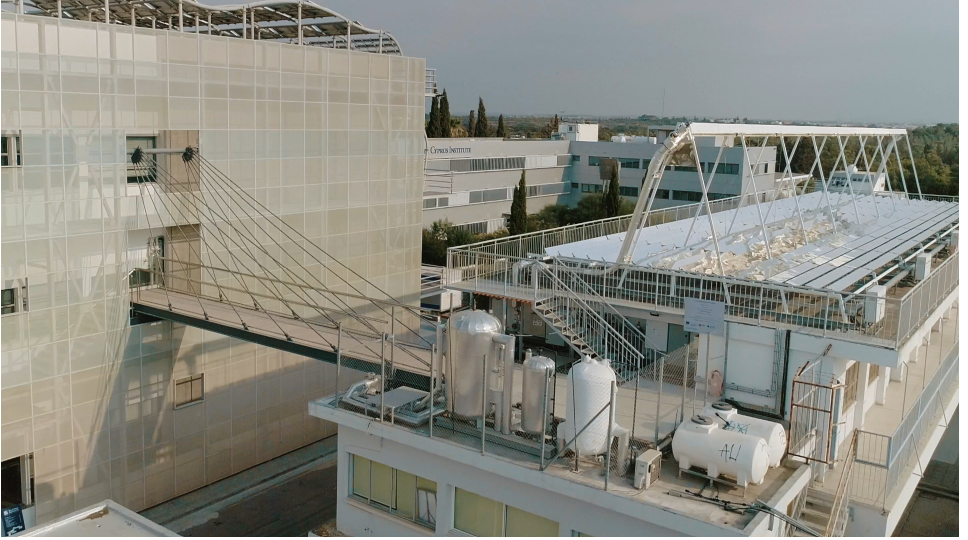
Figure 1. The Linear Fresnel Collector at the Cyprus Institute ( right ) and the Novel Technologies Laboratory [25] ( left